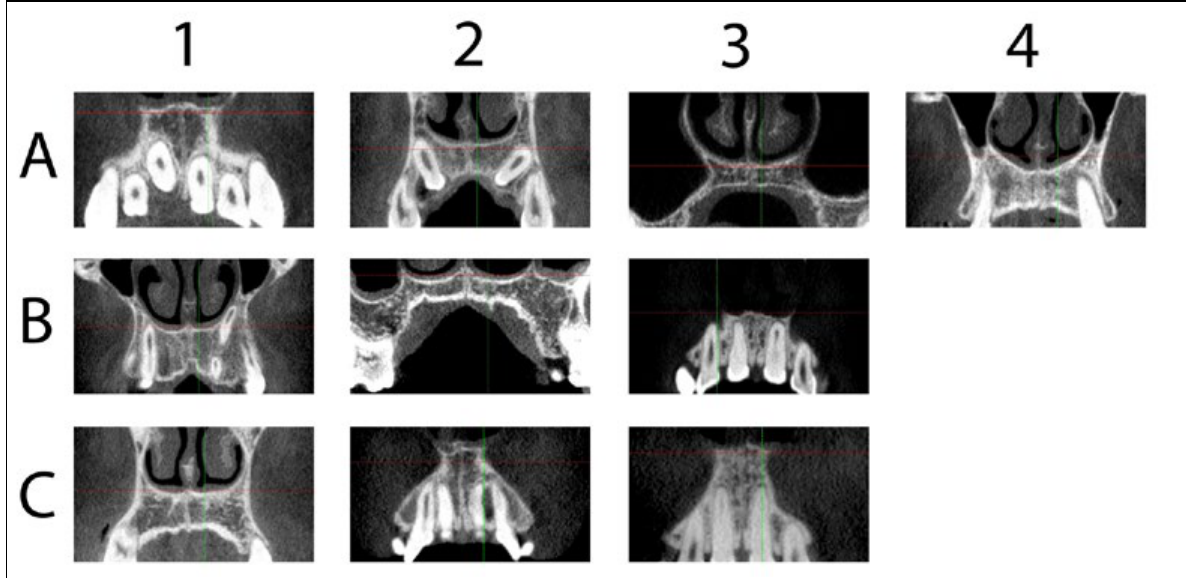
Figure 2. Morphological forms of midpalatal suture. Arabic numbers indicate an observed shape of the suture: 1 – straight, 2 – similar to the polyline, 3 – tortuous shape, 4 – the shape cannot be distinguished from the surrounding hard tissues. Letters indicate the amount of calcified tissue detected within the suture space: (A) radiolucent – with a visible space within the suture along the whole intermaxillary connection with only single isles of radiopaque tissues, (B) partially radiopaque – with a space within the suture seen in approximately 50% of the connection, (C) mostly radiopaque – without the visible space within the suture or with only minor radiolucent spaces within the suture space. Final diagnosis for each point is a combination of the above, with the exception of the diagnosis 4, which was not attributed with a letter.